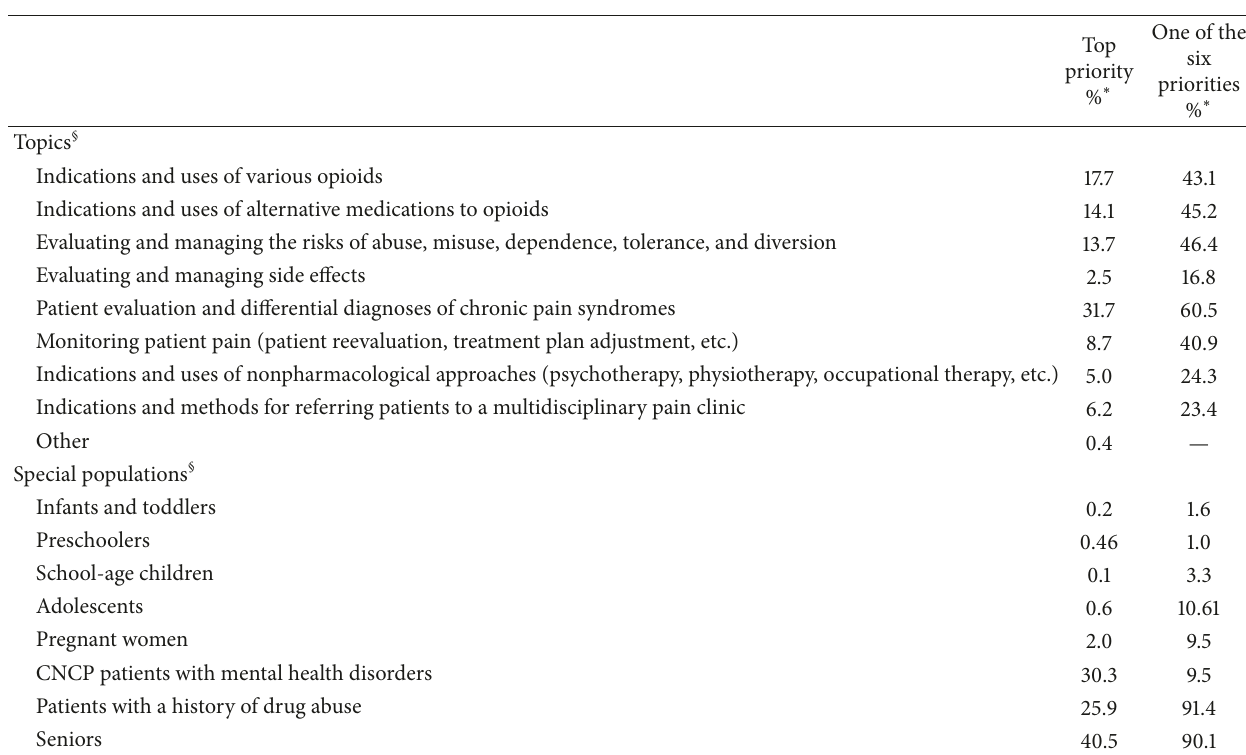
Table 6: Participants’ priorities of training needs ( 𝑁 = 636